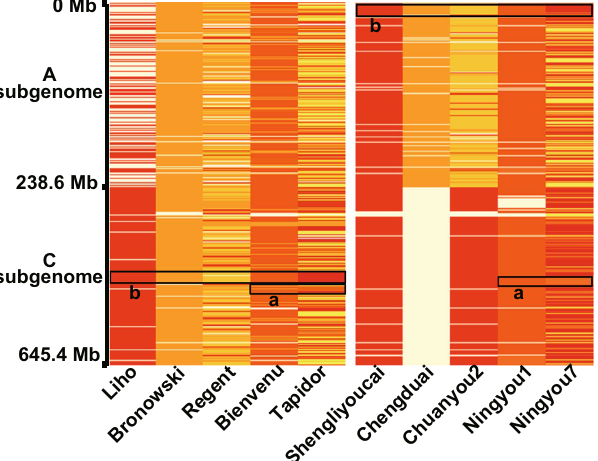
Figure 3. The transfer of identity by descent (IBD) blocks from earlier cultivars to the Tapidor and Ningyou7 cultivars based on SNP markers. Progenitor genomes are indicated by shading for Tapidor (left side) and for Ningyou7 (right). The breeding of both Tapidor and Ningyou7 has selected for IBD from both recent ( a ) and distant ( b ) ancestor cultivars.